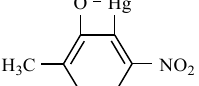
Scheme 6. Sites of action of nimesulide in cellular inflammation.